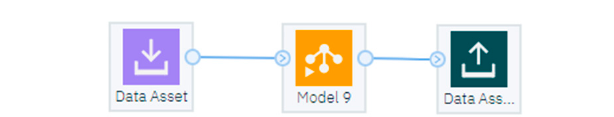
Figure 16. Watson Studio with the data flow stream that uses model 9.